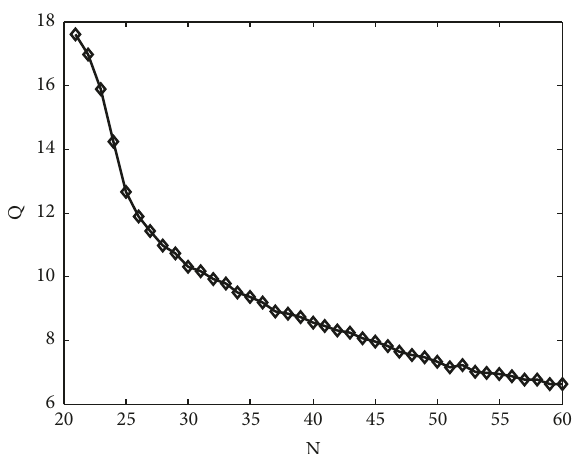
Figure 6: Trend of controllability of WS small-world network with the number of nodes 𝑁 varying across 20,21,. .. ,60 .